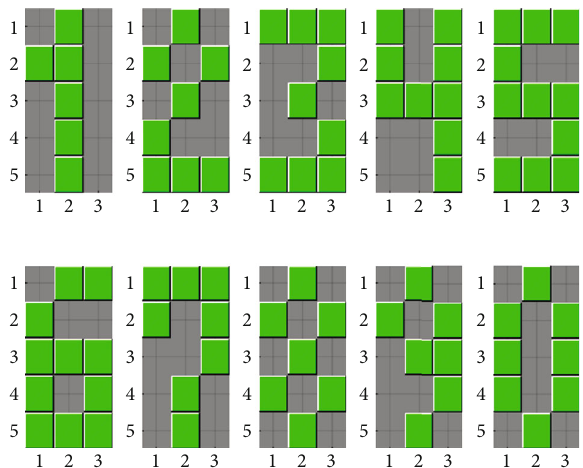
Figure 3: Alphanumeric input patterns presented as inputs to the koniocortex